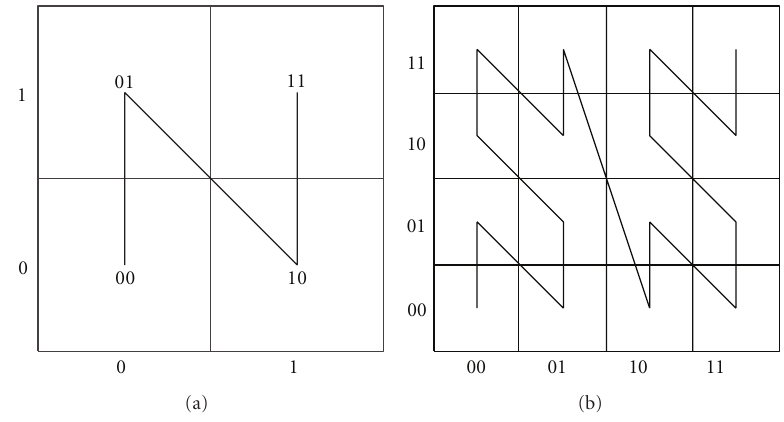
Figure 2: z -order curve approximations: (a) first-order z -curve; (b) second-order z -curve.